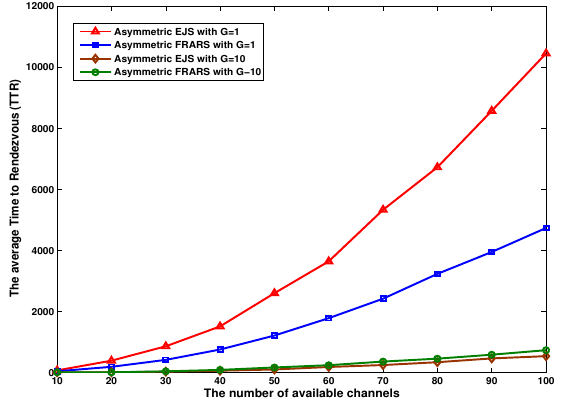
Figure 9. The average Time to Rendezvous (TTR) for the asymmetric FRARS and EJS schemes with | m | = | m | = | M | /2, M = { 10,20, · · · ,90,100 } , and G = { 1,10 } . 2 1